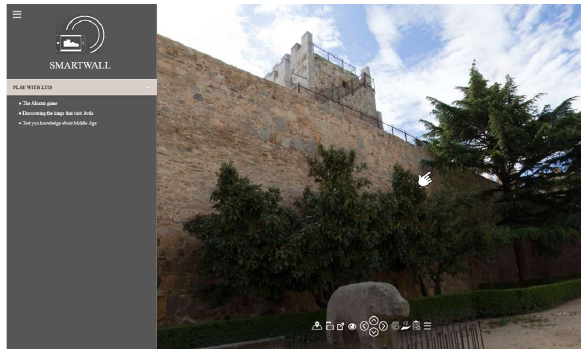
Figure 12. Aspect of the platform SmartWall when the child finds the window on which is placed the key. Once the scholar clicks on it the game ends, showing a brief description of the Alcázar and its role along the